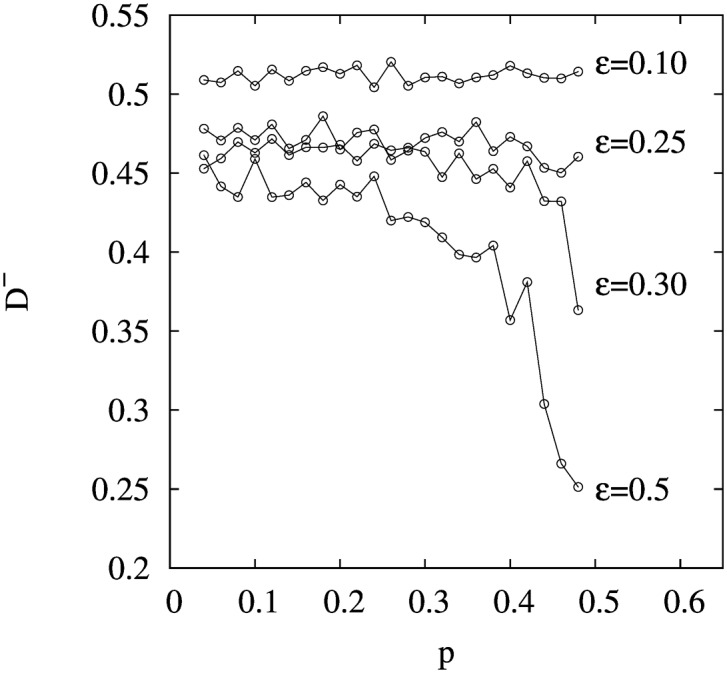
Average of D− in 100 runs as a function of parameters ε and p for a system of 40 agents.